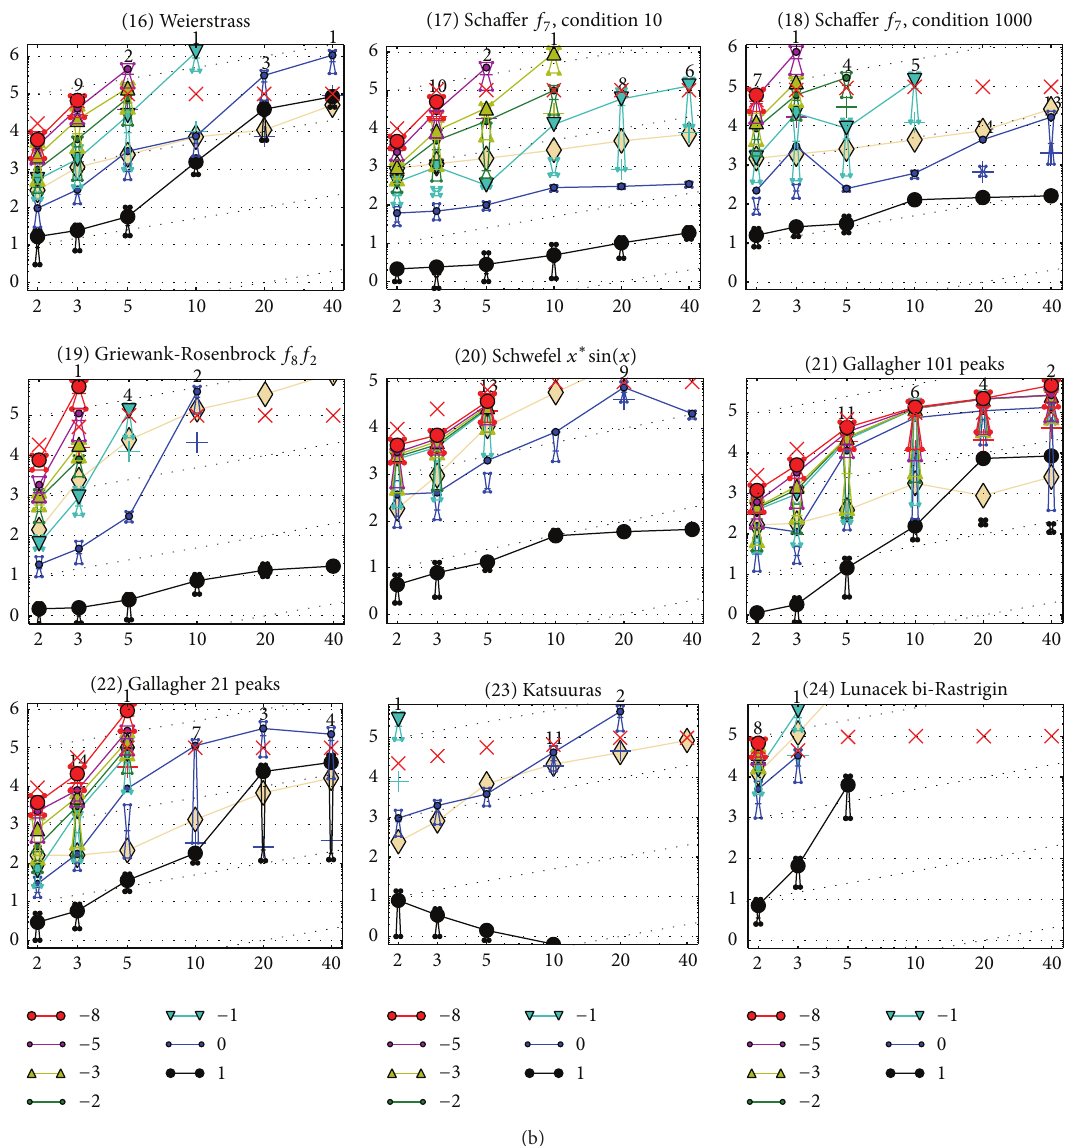
+ Δ𝑓 ; median number of 𝑓 -evaluations (+) to reach the most difficult Figure 1: Expected number of 𝑓 -evaluations (ERT, lines) to reach 𝑓 opt target that was reached not always but at least once; maximum number of 𝑓 -evaluations in any trial ( × ); interquartile range with median +Δ𝑓 ; all values are divided by dimension and plotted as log (notched boxes) of simulated run lengths to reach 𝑓 10 values versus dimension. opt Also, Δ𝑓 = 10 {1,0,−1,−2,−3,−5,−8} are shown. Numbers above ERT-symbols (if appearing) indicate the number of trials reaching the respective targets. The light thick line with diamonds indicates the respective best results from BBOB-2009 for Δ𝑓 = 10 −8 . Horizontal lines mean linear scaling and slanted grid lines depict quadratic